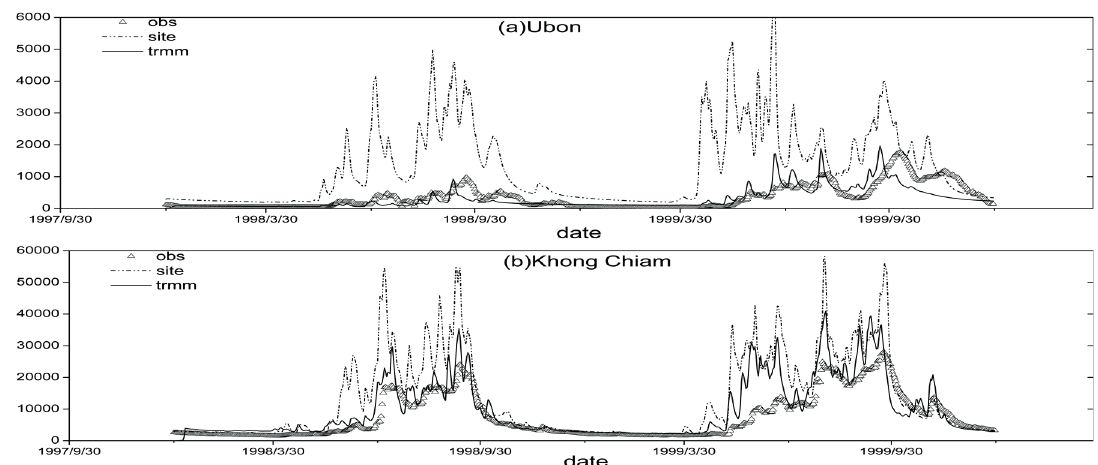
Fig. 5 Time series of daily discharge between at Ubon (a) and Khong Chiam (b) in